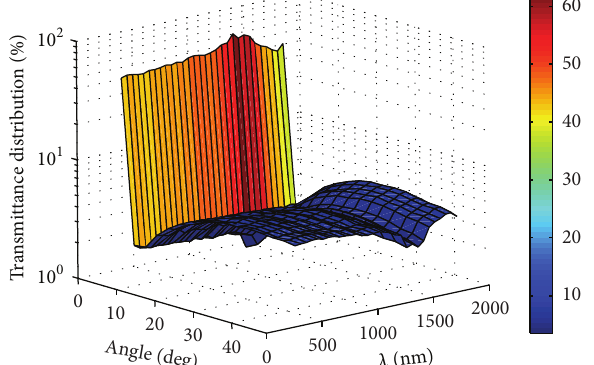
Figure 9: Spectral angular transmittance distribution of the ther- motropic material at 34 ∘ C.